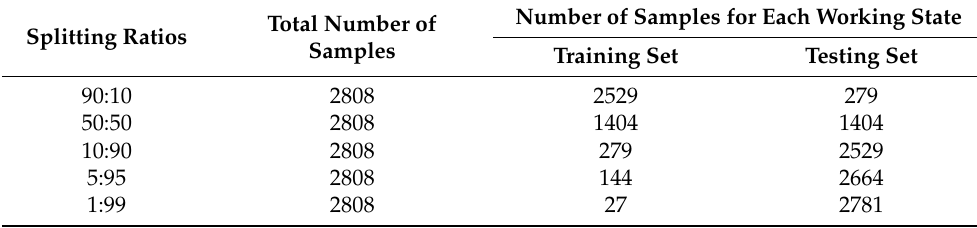
Figure 7. Vibration signals of nine working conditions and their corresponding time-frequency images in the target domain. Table 2. Target-domain training/testing set division under different splitting